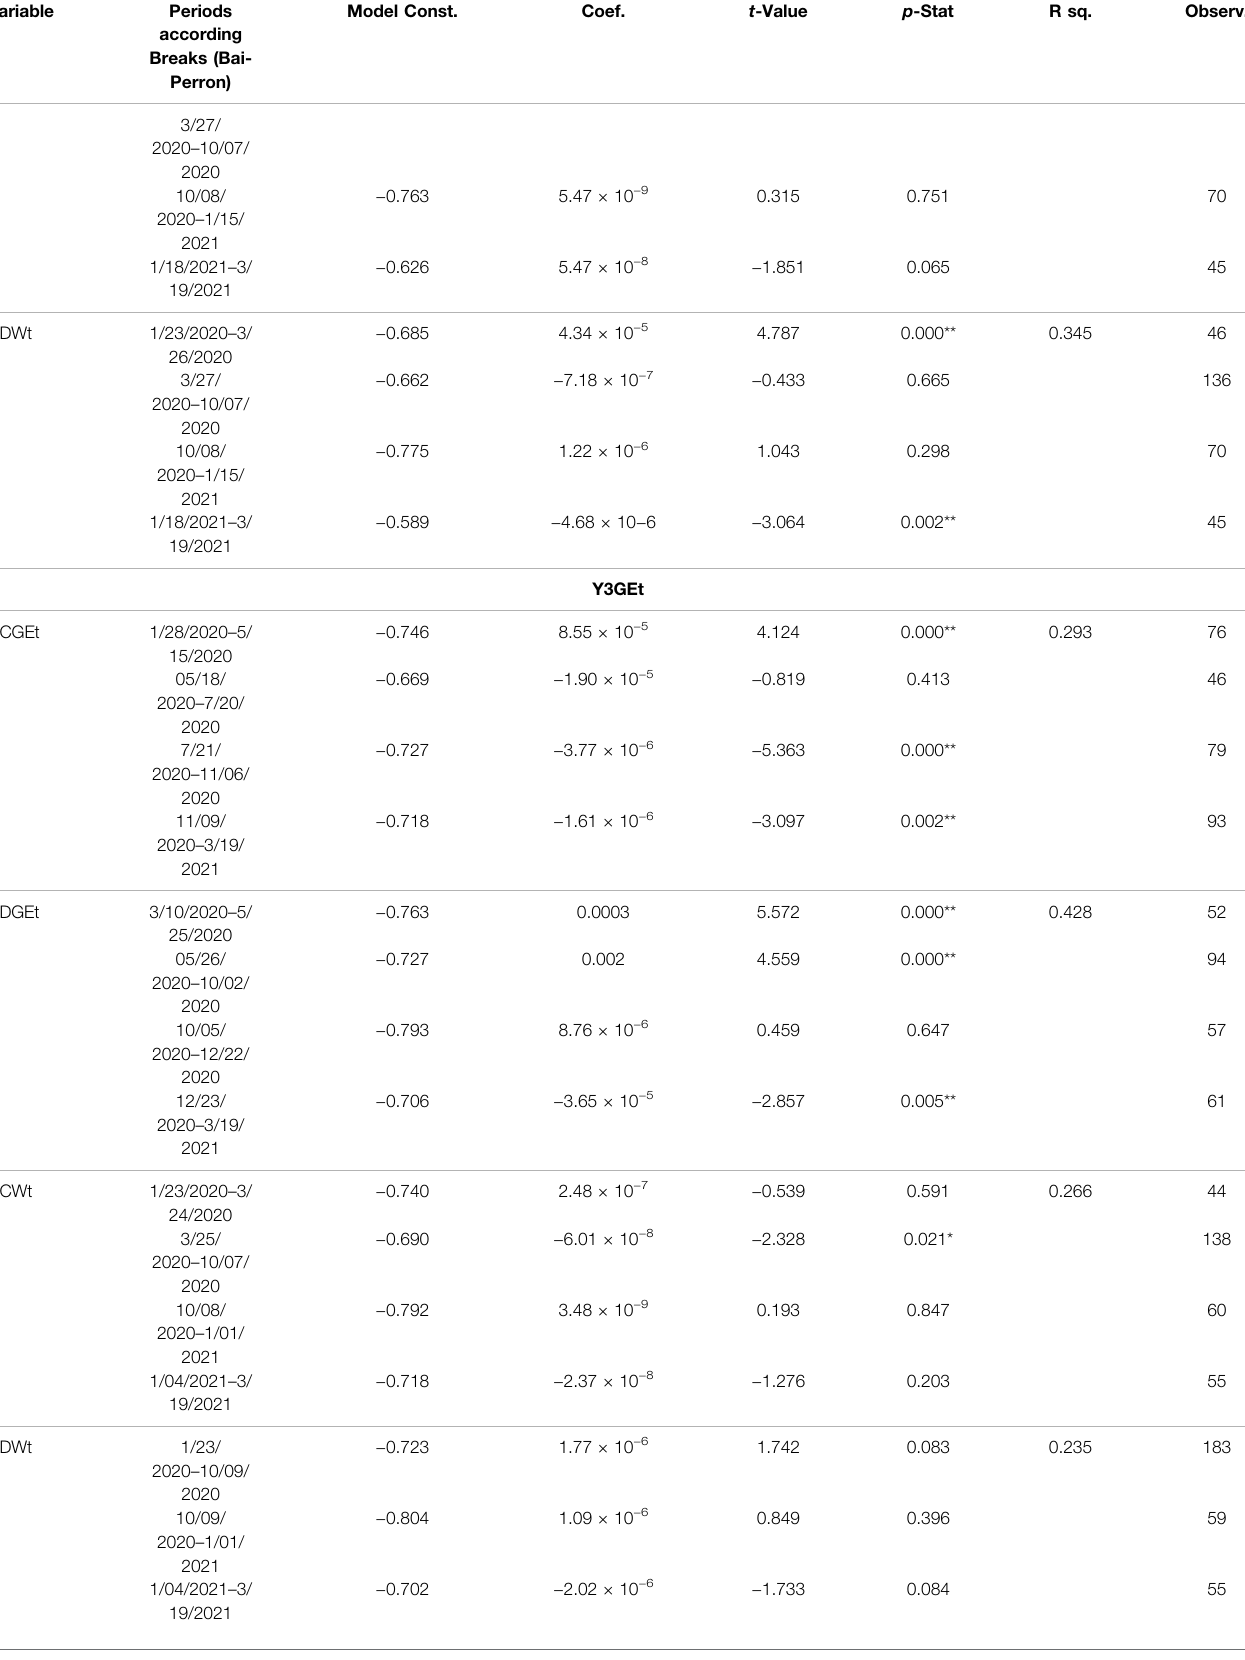
TABLE 2 | ( Continued ) Linear regression (Least Squares with Breakpoints) models for COVID-19 effect on Germany government bond yields. Variable Periods Model Const. Coef. t -Value p -Stat R sq. according Breaks (Bai- Perron)